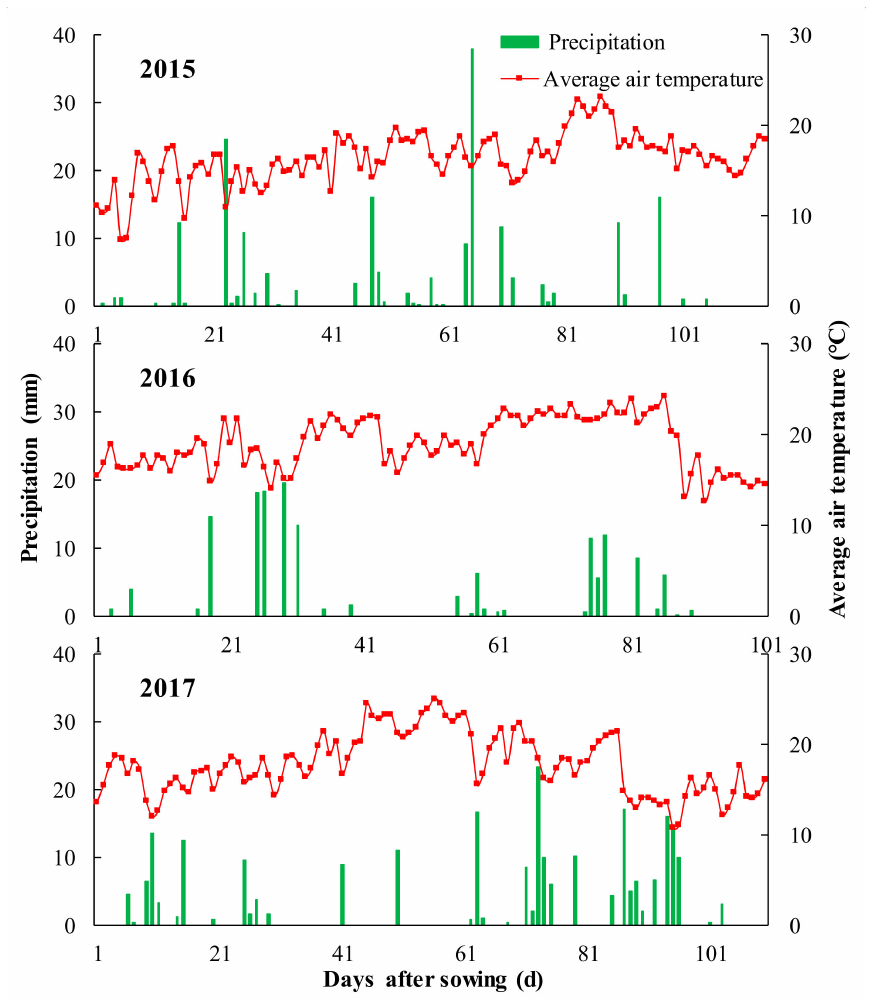
Figure 1. Daily precipitation and mean air temperature during the growing seasons of tartary buckwheat, 2015–2017, at Dingxi Dryland Experimental Station.